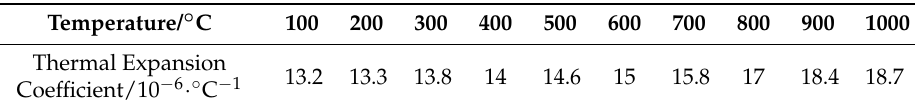
Table 2. Coefficient of thermal expansion of GH4169 alloy.